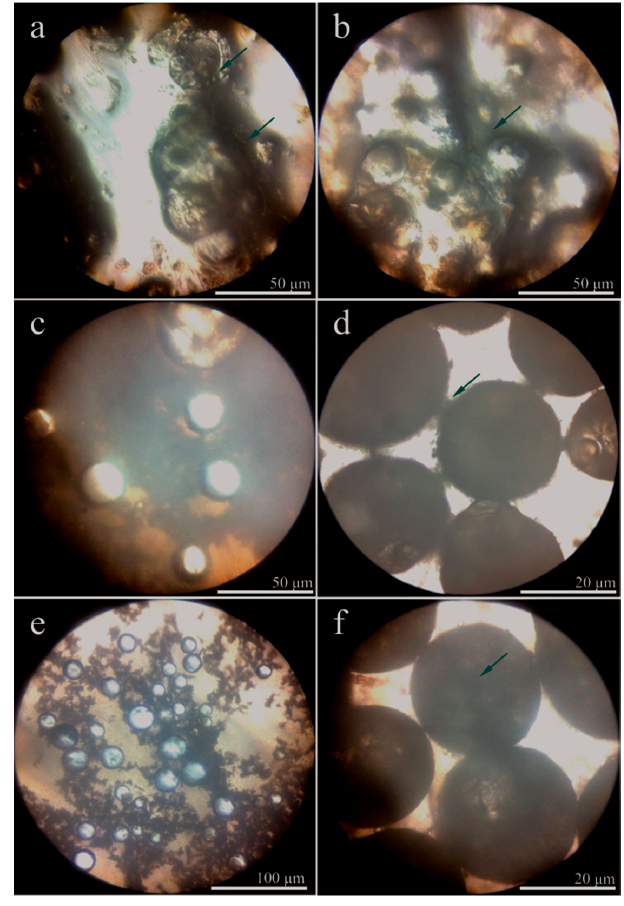
Figure 2. Optical microscope morphologies of microPCMs in emulsion, ( a , b ) core droplets